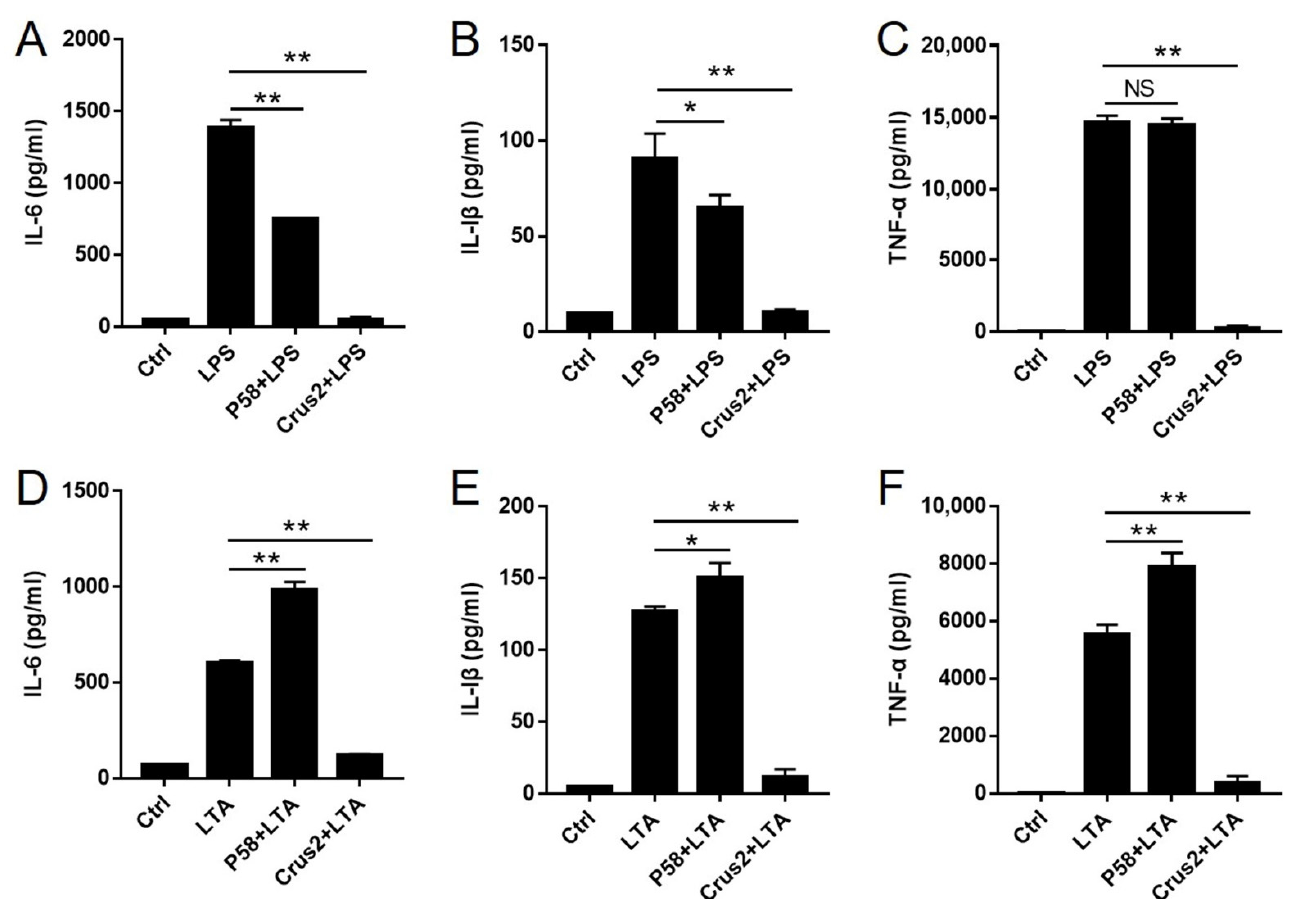
Figure 6. The effects of Crus2 and P58 on LPS- and LTA-induced inflammatory response. ( A – C ) J774.1 cells were incubated with or without (Ctrl) lipopolysaccharide (LPS) that had been pre-incubated with or without Crus2 or P58 for 24 h. The release of inflammatory cytokines (IL-6, IL-1 β , and TNF- α ) was then detected. ( D – F ) J774.1 cells were incubated with or without (Ctrl) lipoteichoic acid (LTA) that had been pre-incubated with or without Crus2 or P58 for 24 h. The release of inflammatory cytokines (as above) was then detected by ELISA. Data are the means triplicate experiments and shown as ± SD. ** and * represent p < 0.01 and p < 0.05, respectively (Student’s t test).